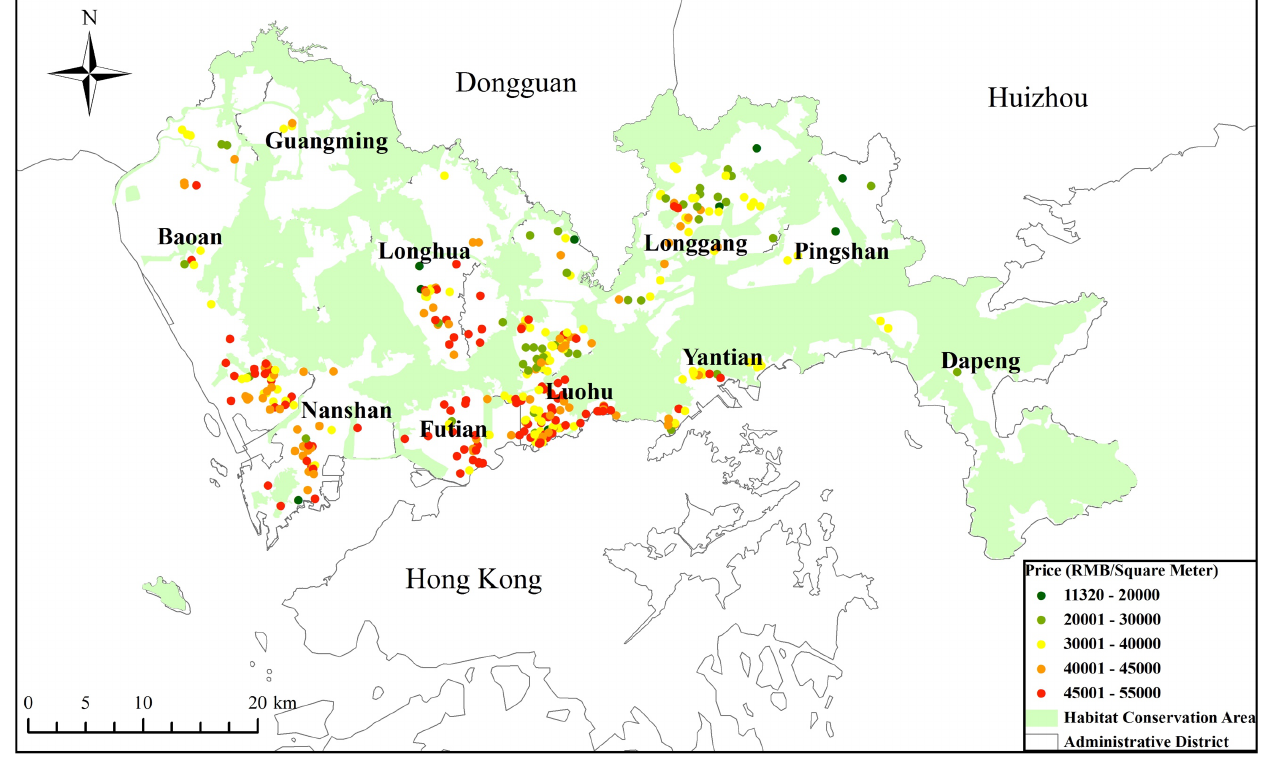
Figure 1. Prices of Housing Estate in Shenzhen